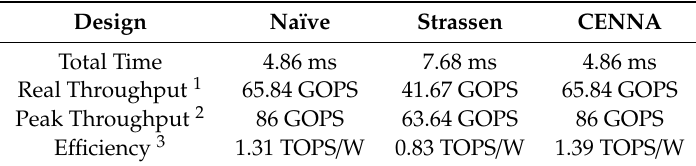
Table 6. Comparison of inference performance running